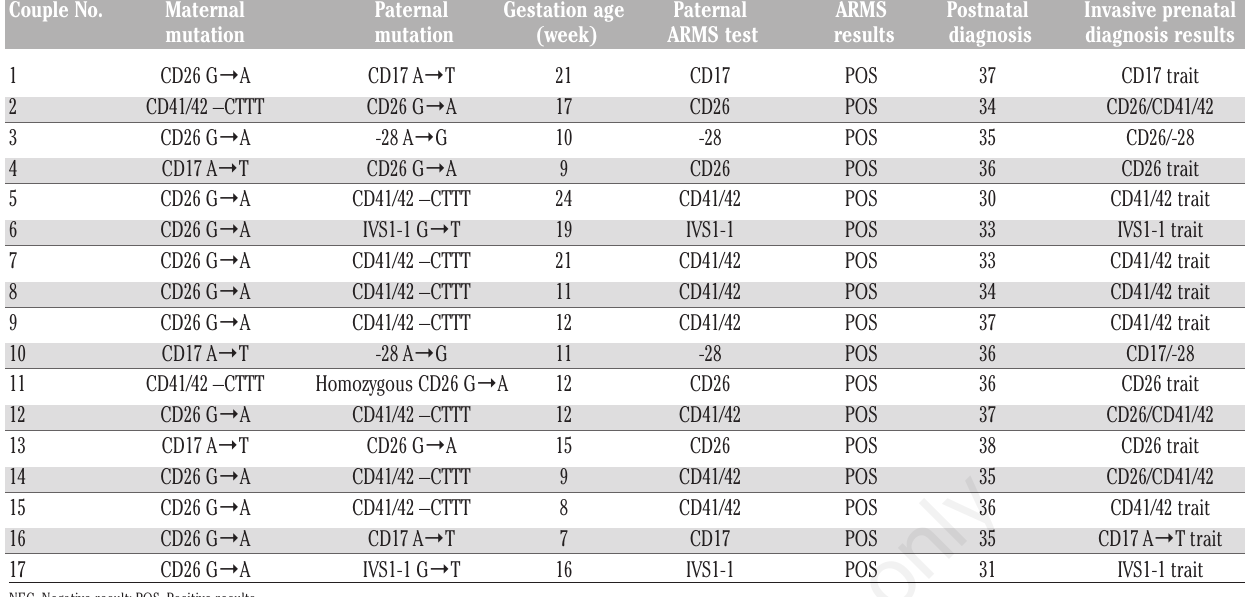
Table 3. The results of the cycle threshold value of positive cases of NIPST using modified ARMS RT-PCR for the detection of PIBTM in the at-risk pregnancies. Couple